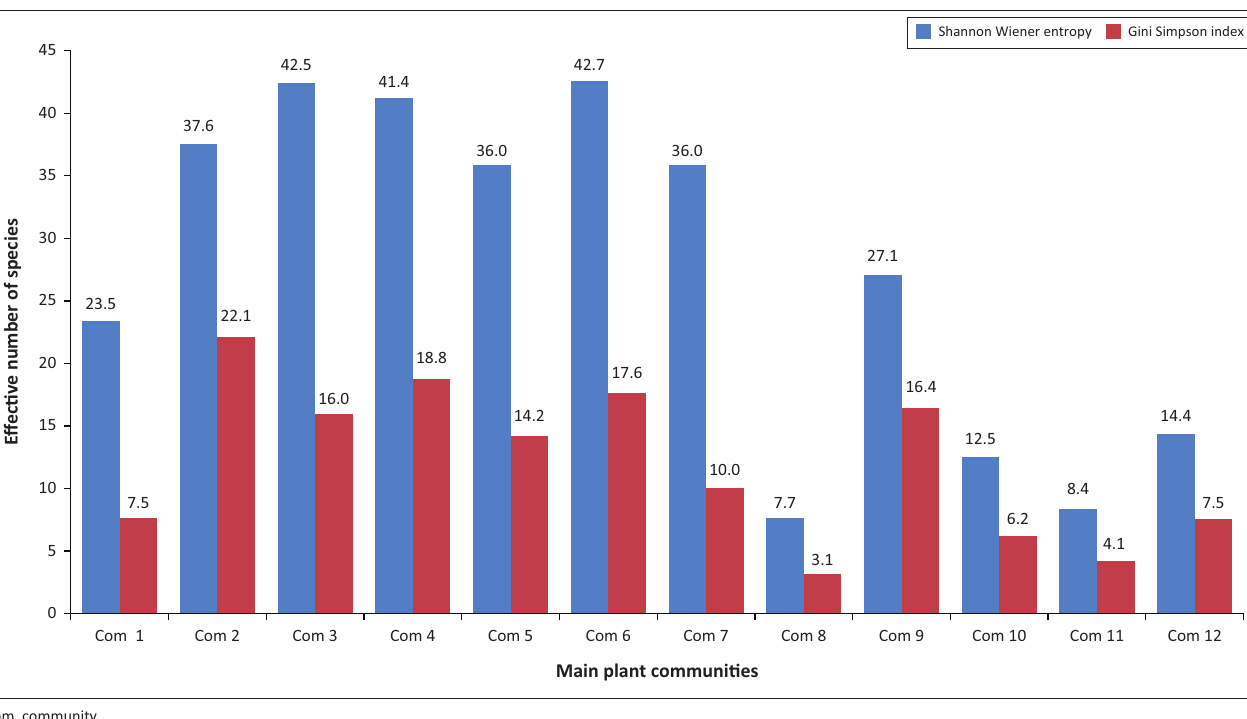
FIGURE 3: Species diversity (Shannon-Wiener & Gini Simpson Index) for the main plant communities of the mountainous Waterberg section of Marakele National Park.